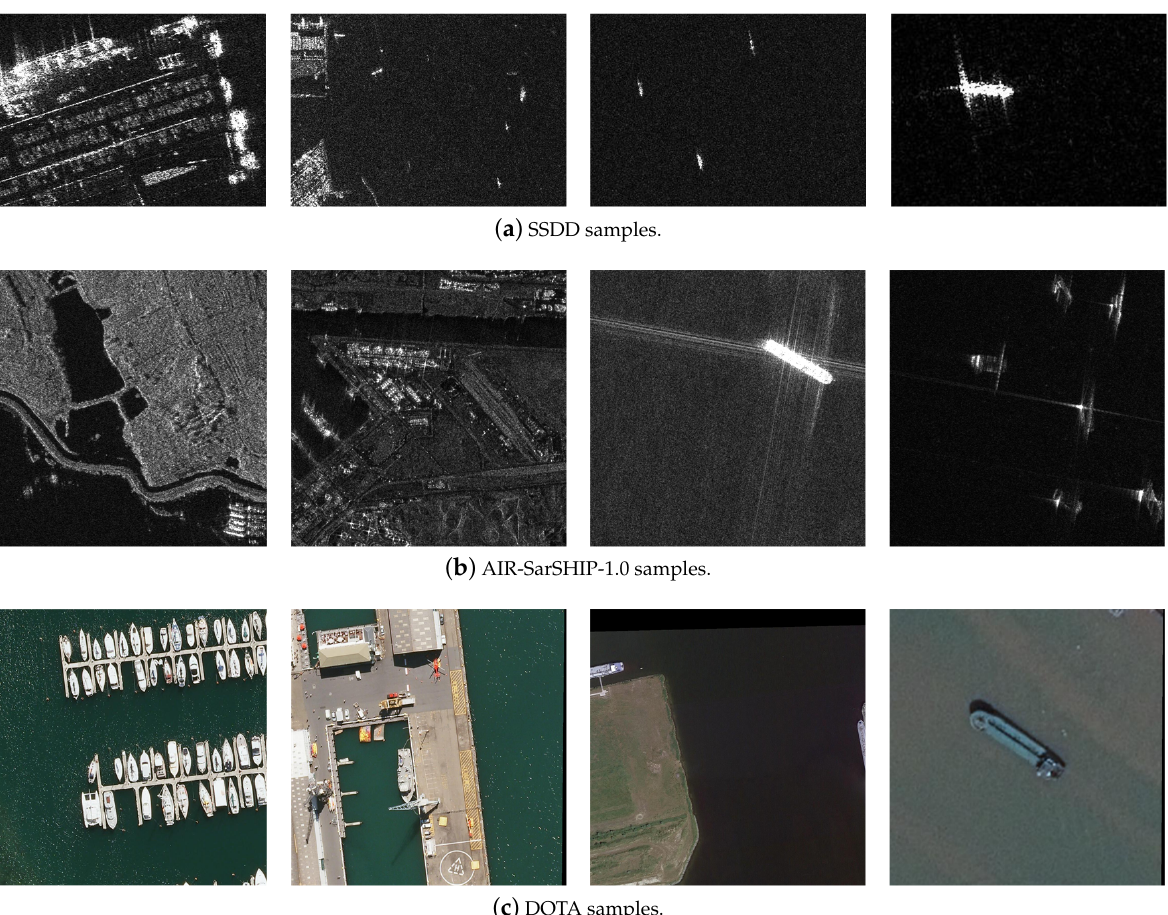
Figure 4. Samples from the datasets. Three remote sensing ship datasets are used in the experiments to evaluate the proposed method, including two SAR datasets SSDD and AIR-SarSHIP-1.0, and one optical remote sensing image dataset